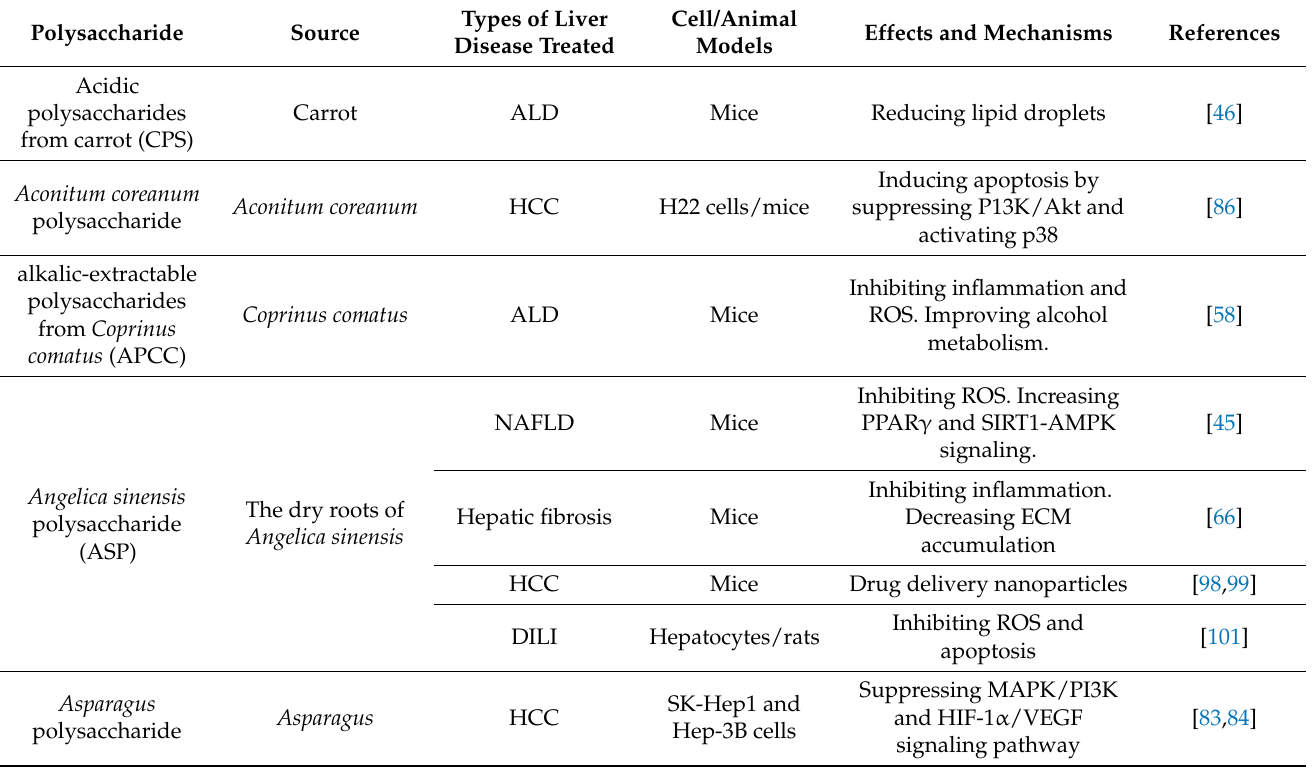
Table 1. Polysaccharides in liver